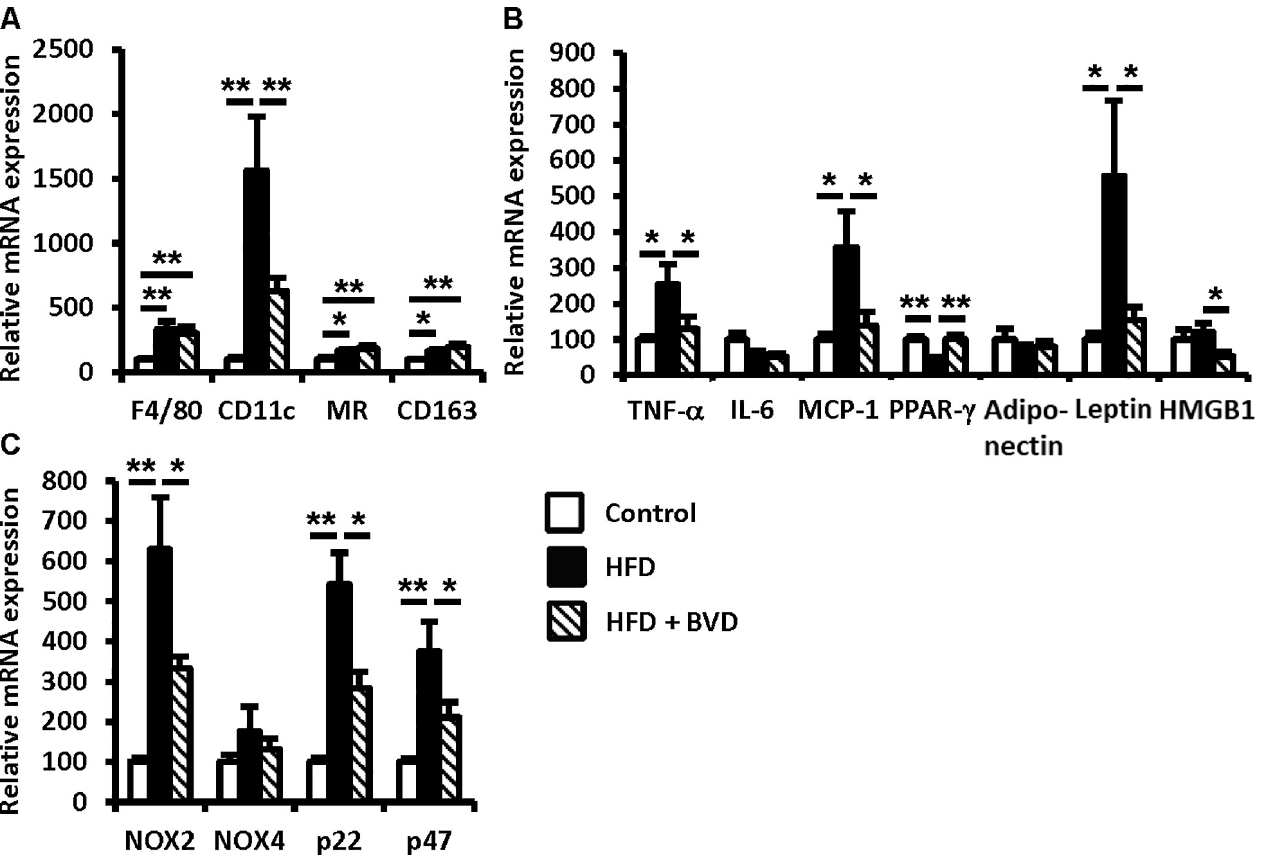
Fig 3. Effect of biliverdin (BVD) on gene expression. The expressions of macrophage markers (A), adipocytokines (B), master regulators of adipogenesis (B), and NAD(P)H oxidase components (C) were measured in white adipose tissue. Total RNA was extracted from the white adipose tissues of control mice (open bars), high-fat diet (HFD)-fed mice (closed bars) and HFD mice treated with biliverdin (BVD) (hatched bars). mRNA expression was measured using real- time RT-PCR and normalized to the expression of β -actin . Results are expressed as means ± SEM. (n = 8). � P < 0.05 and �� P < 0.01 (ANOVA).